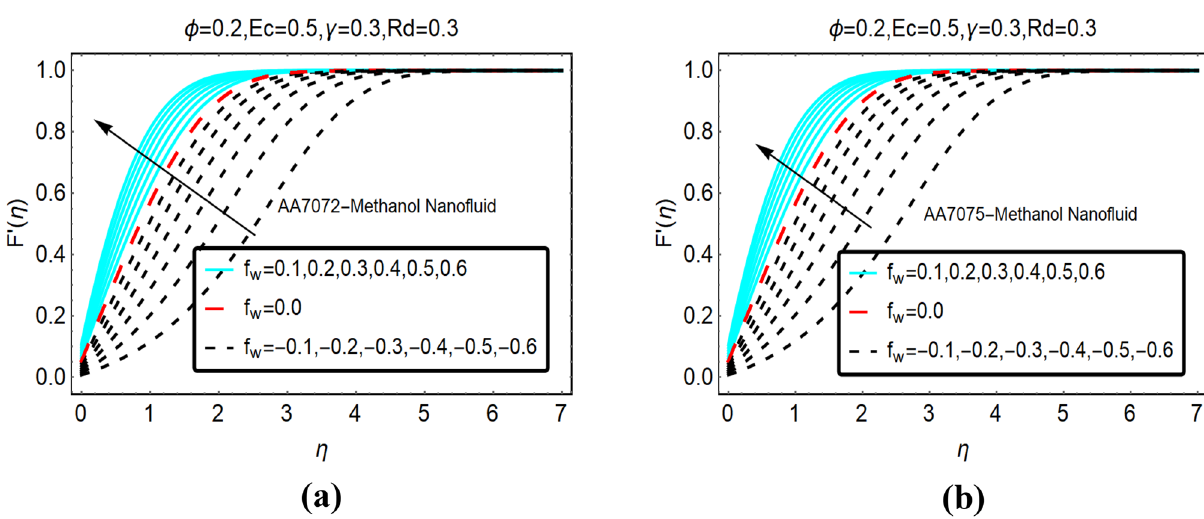
Figure 3. The effects of f w on F ′ (η) ( a ) AA7072-Methanol ( b )